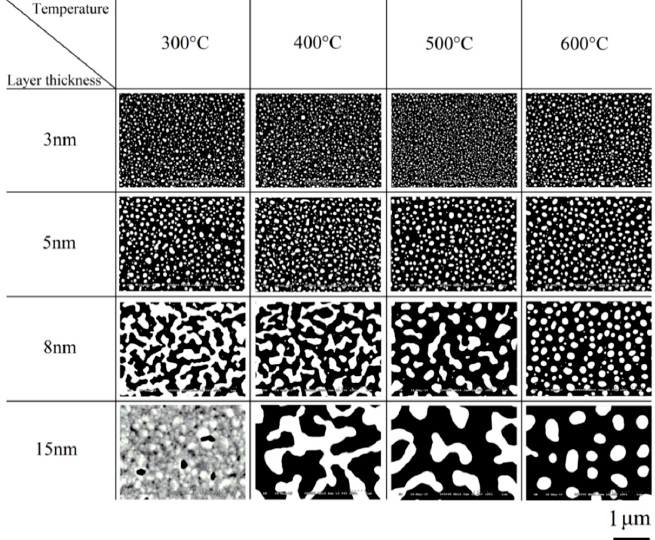
Figure 2. Scanning electron microscopy images taken of silver nanoparticles as a function of temperature and thickness of the deposited layer (see the details in the text).